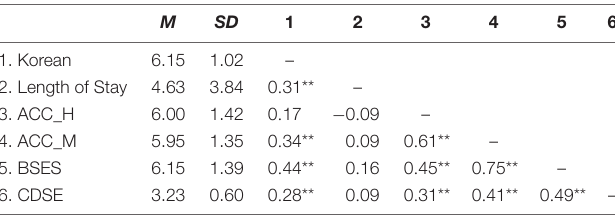
TABLE 1 | Means, standard deviations, and correlations among variables.